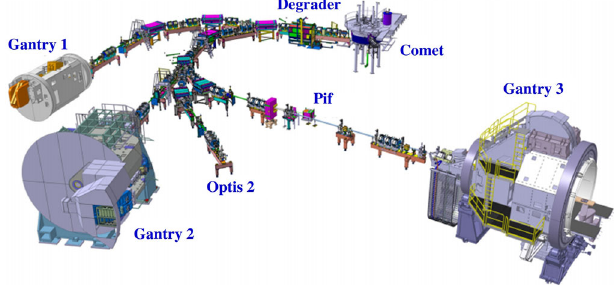
FIG. 1. Schematic layout of the PROSCAN facility